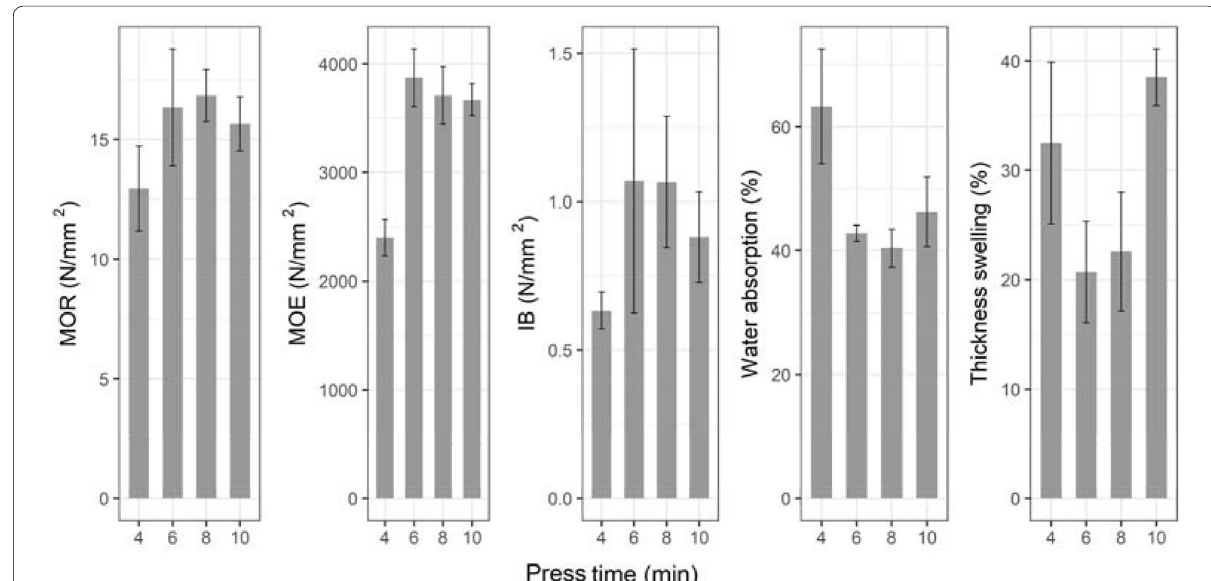
Fig. 2 Dimensional stability and mechanical properties of jute stick binderless particleboard (JBPB) pressed at 220 °C as a function of press times. Error bar indicates the standard